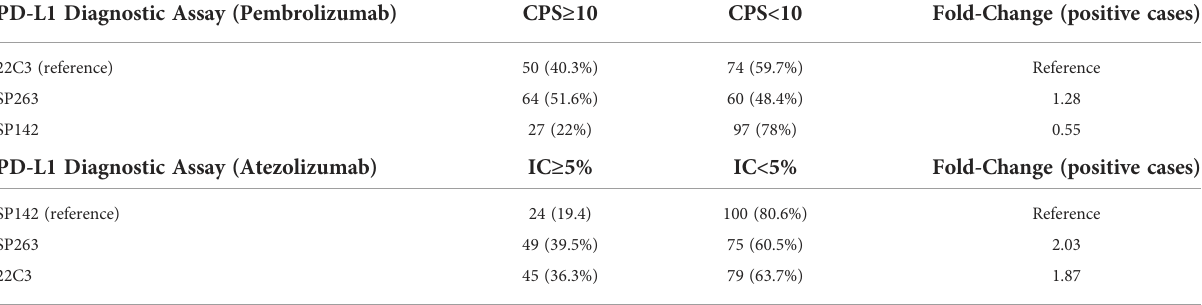
TABLE 4 Number of patients de fi ned as eligible for treatment according to assay, scoring algorithm, and therapy. PD-L1 Diagnostic Assay (Pembrolizumab)